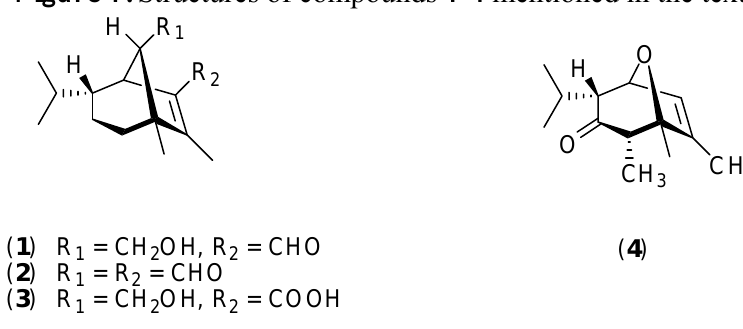
Figure 1. Structures of compounds 1-4 mentioned in the